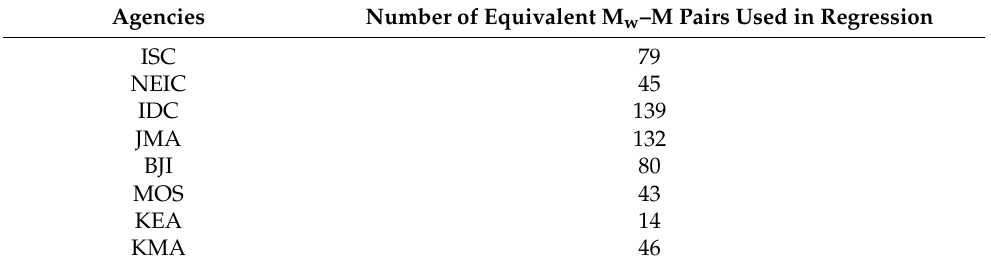
Table 3. Number of earthquakes with a listed M w as well as another magnitude type categorized by agency. Agencies Number of Equivalent M w –M Pairs Used in Regression ISC 79 NEIC 45 IDC 139 JMA 132 BJI 80 MOS 43 KEA 14 KMA